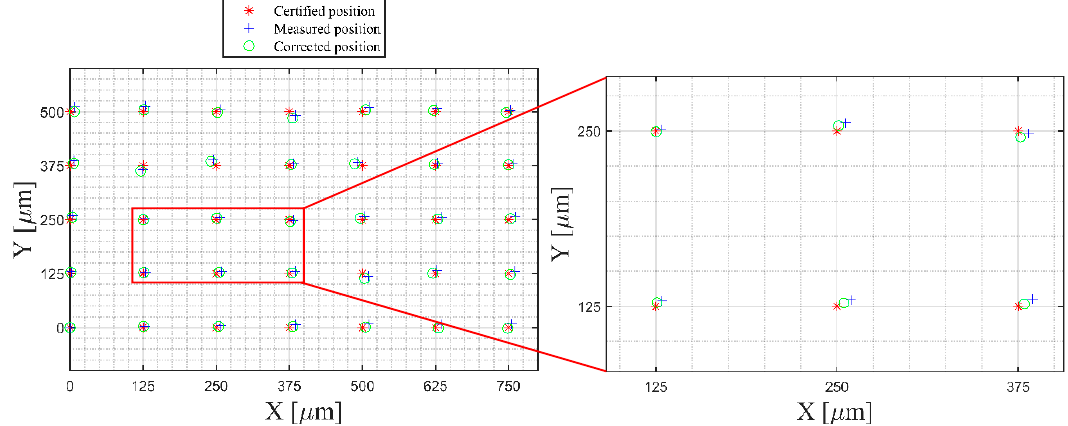
Figure 14. Comparison of the positions of certified, measured and corrected points.